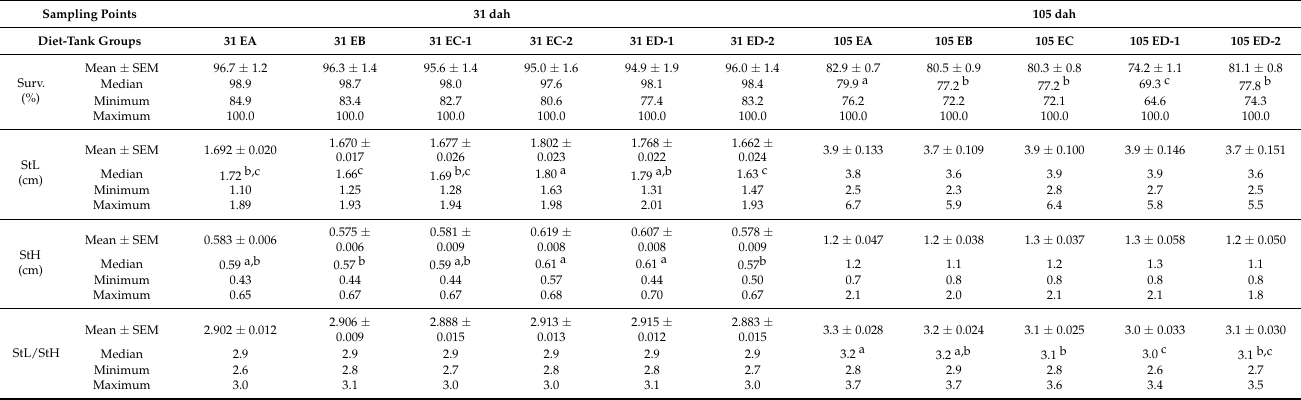
Table 7. Daily survival rate (%) and biometric results for standard length (StL), standard height (StH), and the ratio StL/StH for each diet-tank group (31 EA, 31 EB, 31 EC-1, 31 EC-2, 31 ED-1, 31 ED-2, 105 EA, 105 EB, 105 EC, 105 ED-1, 105 ED-2): mean ± standard error of the mean, median, minimum, and maximum. dah: days after hatching; SEM: standard error of the mean; Surv.: daily survival rate.